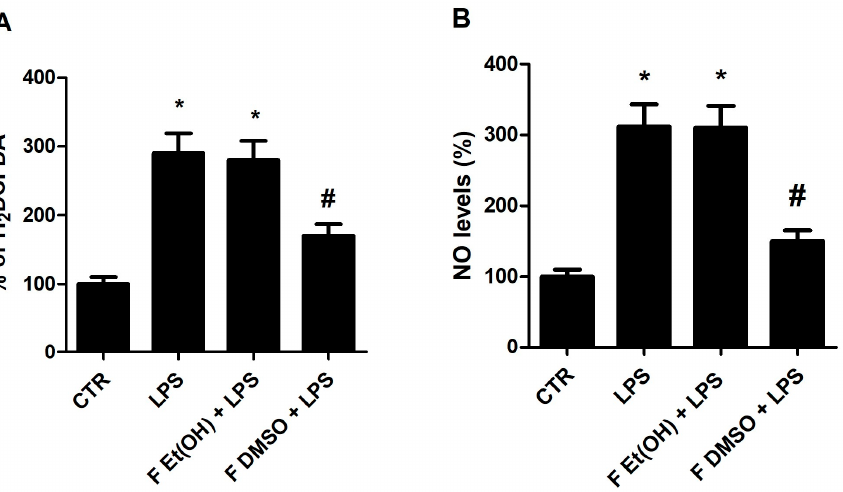
Figure 4. The effect of VGEs and D-VGEs on the modulation of LPS-stimulated oxygen radical release (DCFDA) ( A ) and NO ( B ) in macrophage RAW 264.7 cells. * p < 0.01 versus control (CTR). # p < 0.01 toward LPS. Analysis by ANOVA followed by Dunnett’s test, N = 3.